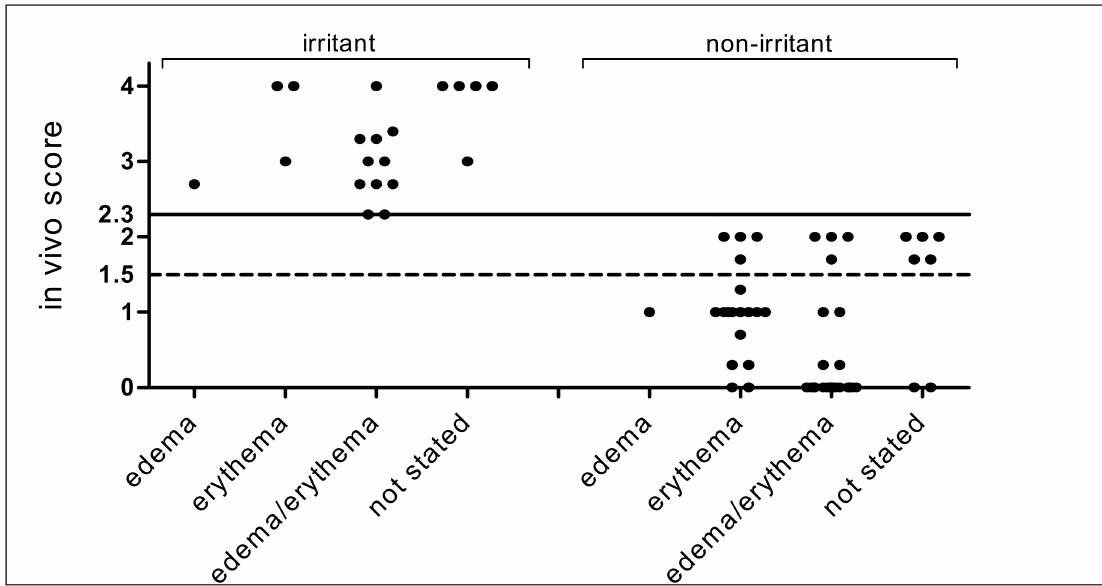
Figure 4. Scatter plot of edema/erythema in vivo Draize scores of 86 chemicals excluding Cat 1 chemicals according to irritant and non-irritant classification. The scatter plot shows the distribution of the in vivo Draize test scores. The value of 2.3 on the Y-axis indicates the in vivo score classification cut-off. The in vivo score 1.5 is marked to identify Cat 3.